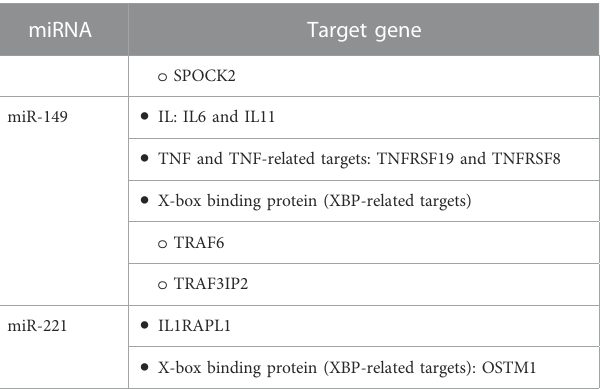
Only 4 or less targeted genes are listed here. If there are more than 4 genes involved, only the name of the group is listed, i.e., Interleukins (ILs). ILS: interleukins;